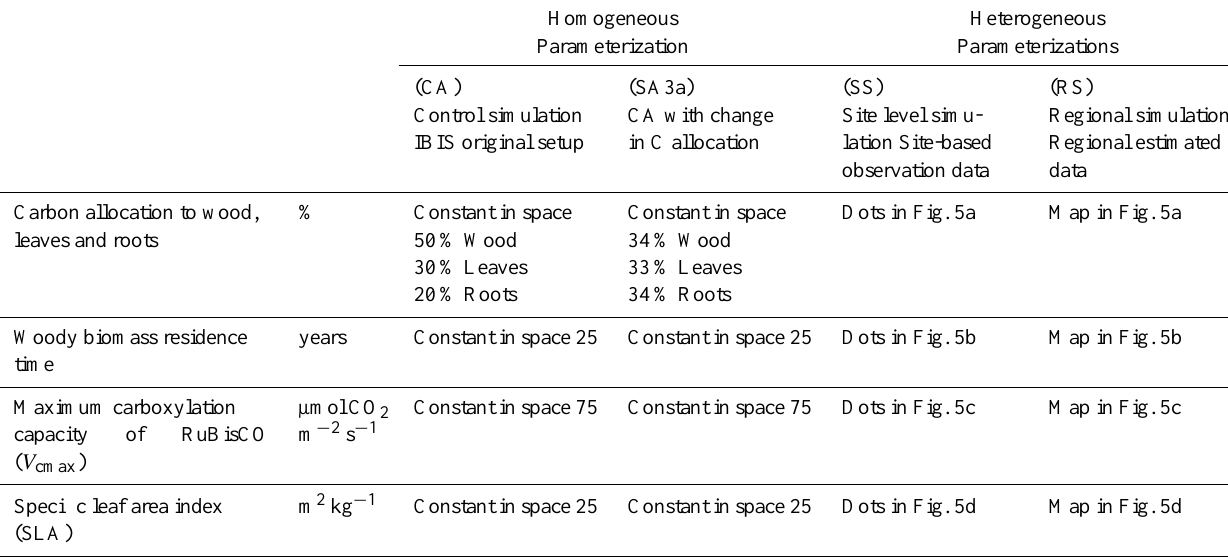
Table 2. Summary of the parameterization setup for each of the simulation experiments: the control simulation (CA) with the original IBIS- prescribed homogeneous parameterization; the SA3a with corrected carbon allocation, with homogeneous parameterizations in space; site level simulation (SS) with heterogeneous parameterizations represented; and the regional simulation (RS) with the upscale of the respective parameters.